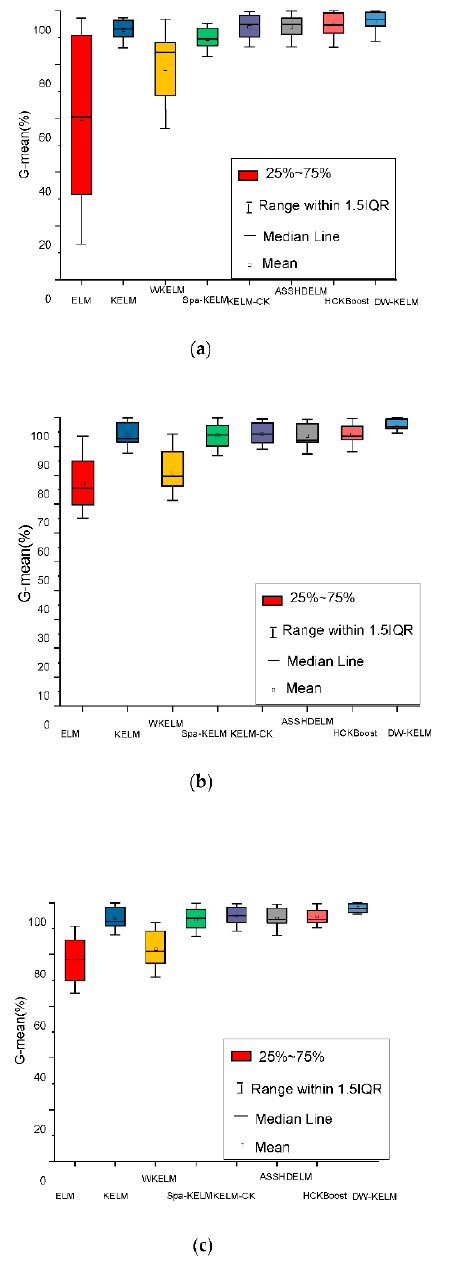
Figure 8. G-mean (%) on the ( a ) Indian Pines, ( b ) Pavia University, and ( c ) Salinas images.